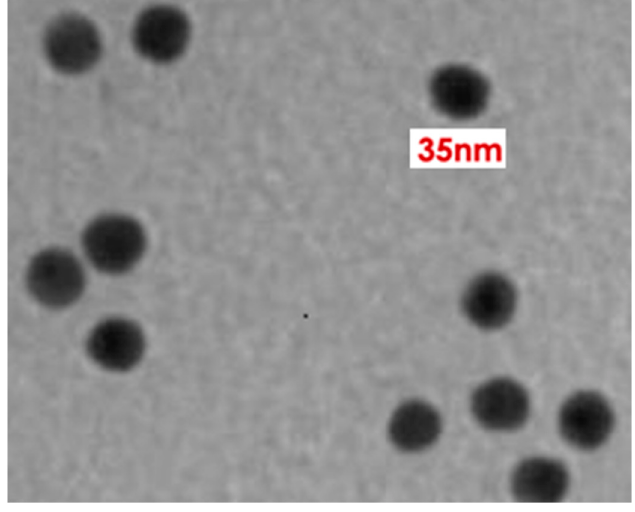
Figure 4. TEM analysis of AuNPs.